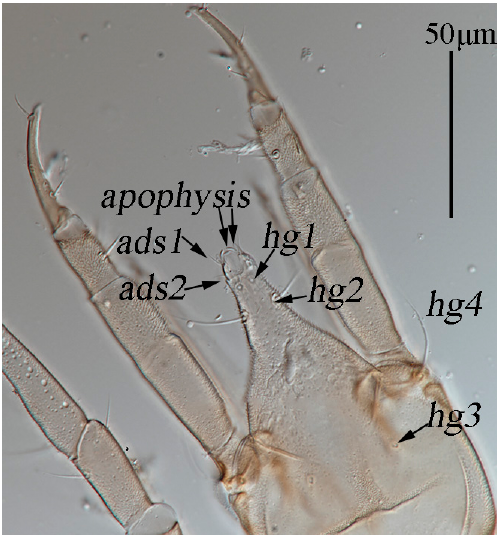
Figure 6. Cunaxicaudus mohanensis sp. nov . (male). Gnathosoma (photo). Scale bar = 50 µm.